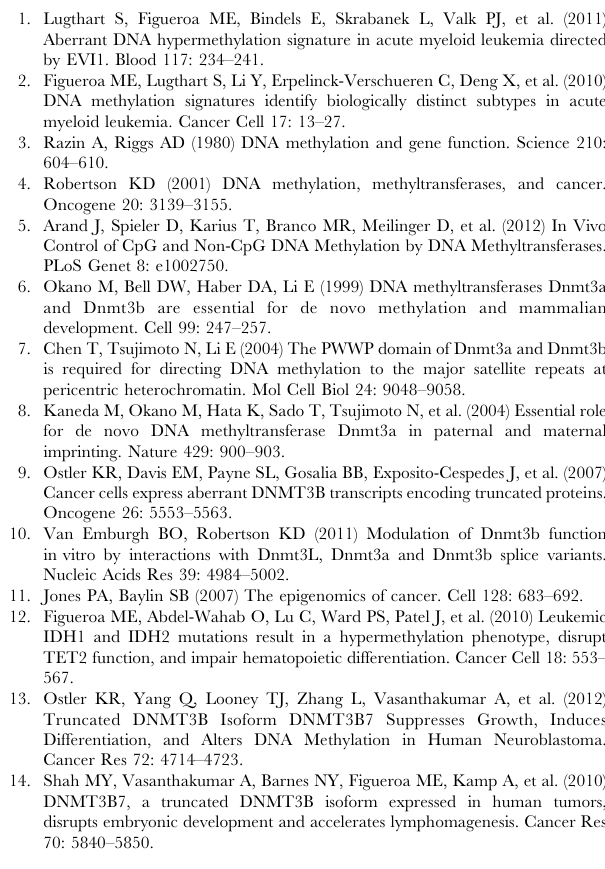
Figure S1 HRM analysis of DNMT3A exon 23 muta- tions. A. HRM profiles of 8 patients (in duplicate) harbouring DNMT3A exon 23 mutations (red) compared to 20 negative patients (blue). B. The sensitivity of the test ( , 2.5%) was obtained from the dilution of R882H mutated samples in non mutated cDNA (undiluted: heterozygous rate at 50%); Analysis was performed on the LC480 Roche device. Positive detected dilutions in red.